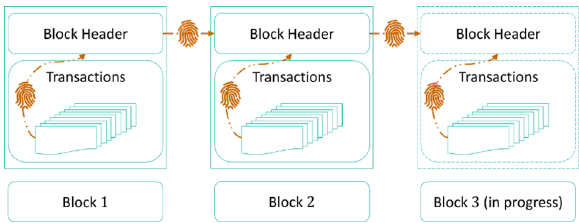
Figure 3: Bitcoin Blockchain Data